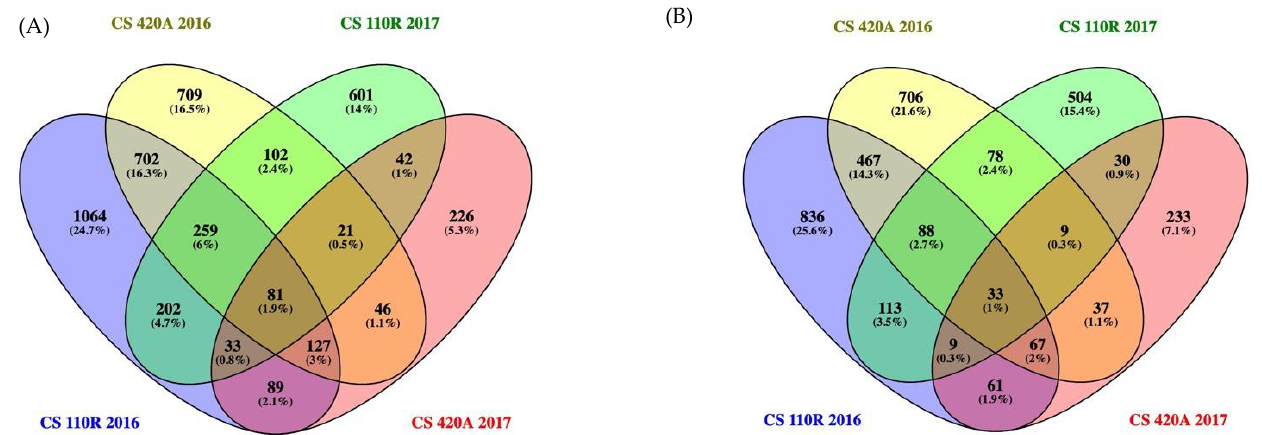
Figure 4. Venn Diagram of upregulated differentially expressed genes ( A ) and downregulated differentially expressed genes ( B ) for each rootstock and season. The genes at each ripeness level were pooled for each rootstock and season combination to find the conserved up and downregulated genes due to GRBV infection. CS = Cabernet Sauvignon.